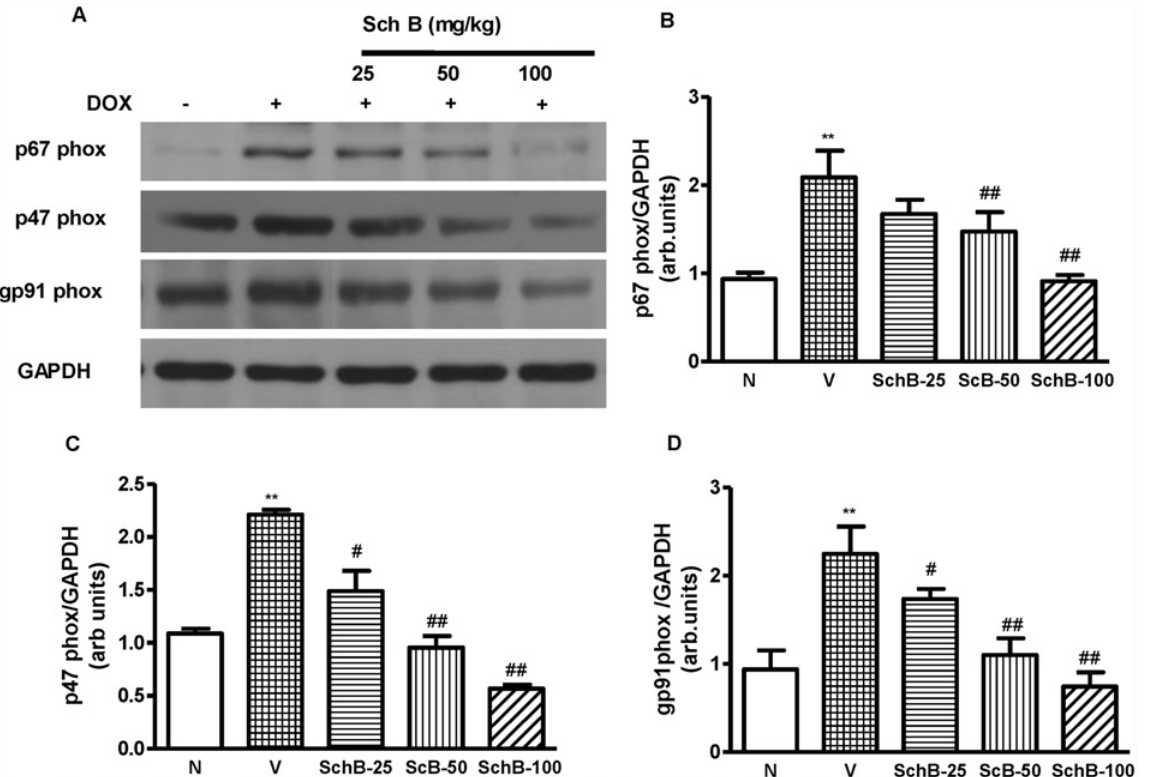
Fig 8. Sch B inhibits Dox induced NADPH oxidase subunits. (A – D) Representative Western immunoblots and densitometry analysis using Scion image software for p47phox, p67phox and gp91phox in group N, group V and Sch B treated mice; Blots were normalized against GAPDH. Each bar represents means ± S.E. (n = 3 – 5). ** P < 0.01 vs. group N mice; # P < 0.05 and ## P < 0.01 vs. group V mice.